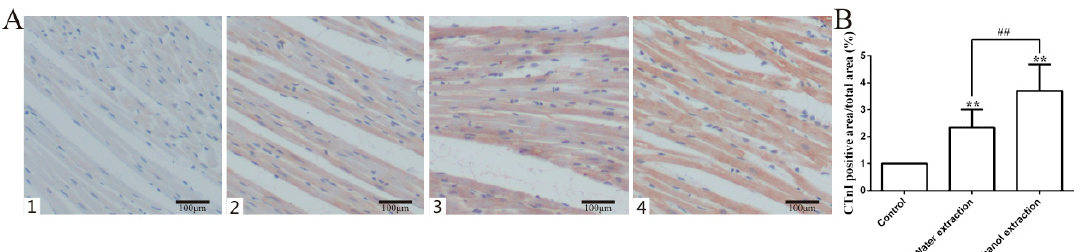
Figure 1. CTnI, CK-MB, LDH, and catecholamine levels in serum measured by ELISA and colorimetric analysis. ( A ) Representative figure of serum CTnI content. ( B ) Representative figure of serum CK-MB content. ( C ) Representative figure of serum LDH content. ( D ) Representative figure of serum catecholamine content. Data are expressed as mean ± SD, n = 8. * p < 0.05, ** p < 0.01 vs. control group; # p < 0.05, ## p < 0.01 vs. water extraction group.